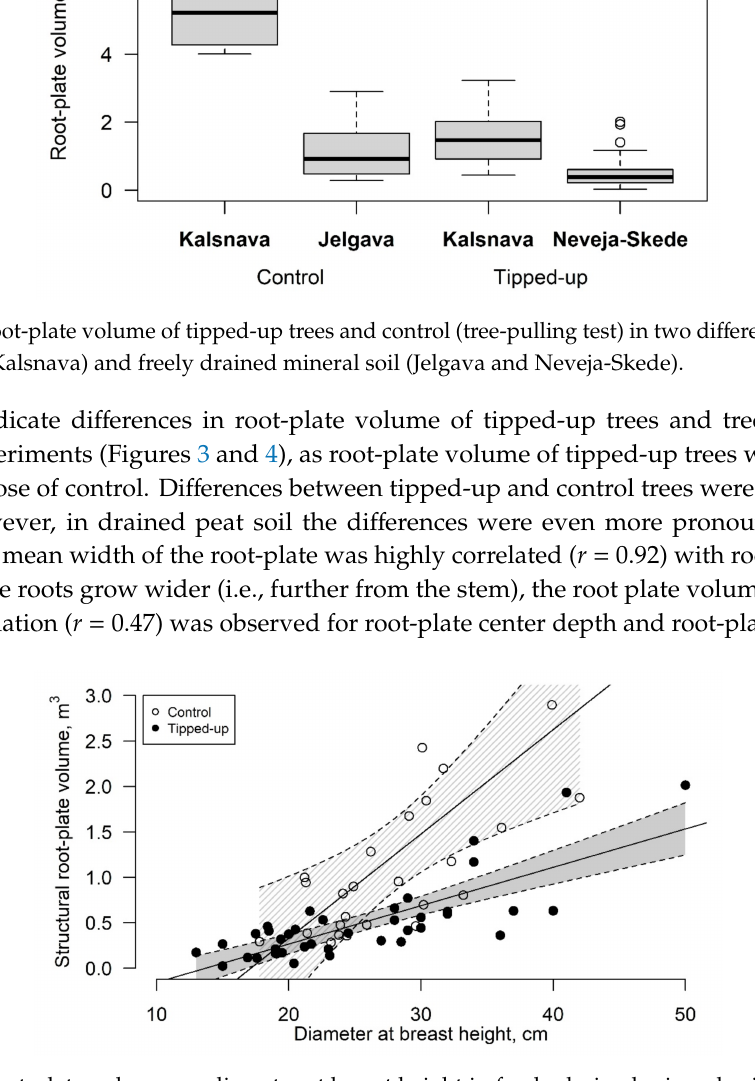
Figure 3. Root-plate volume vs. diameter at breast height in freely drained mineral soil. Grey area indicates 95% confidence